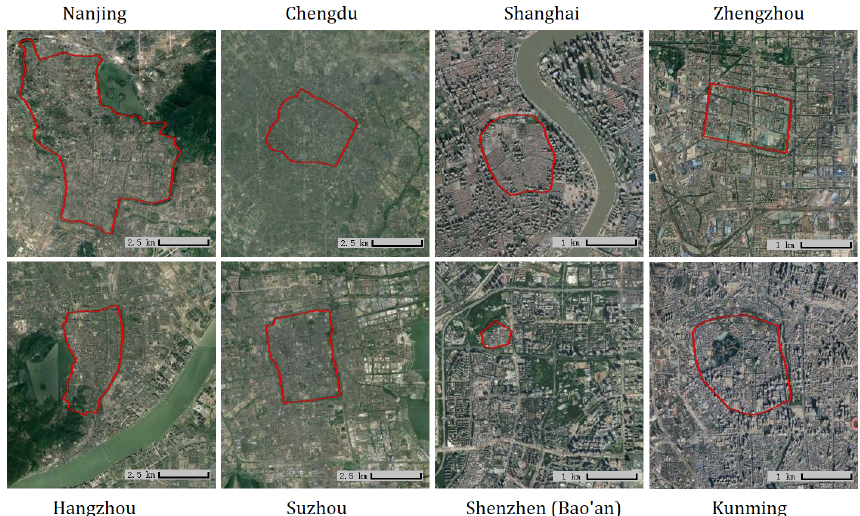
Figure 5. Several extents of city walls of Chinese cities from 1368 to 1911. The red aerials are from the China City Wall Areas Dataset (CCWAD) which illustrate the location of city walls. These maps are based on © Google Earth image, 2020.